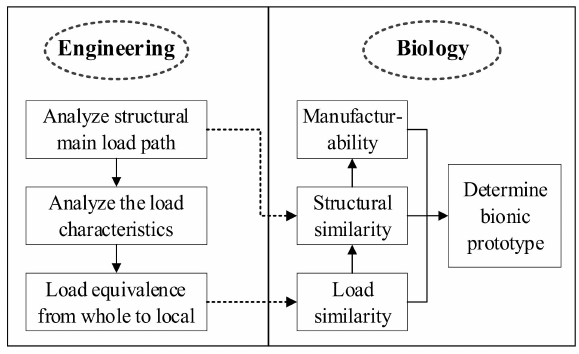
Figure 6. Selection of bionic